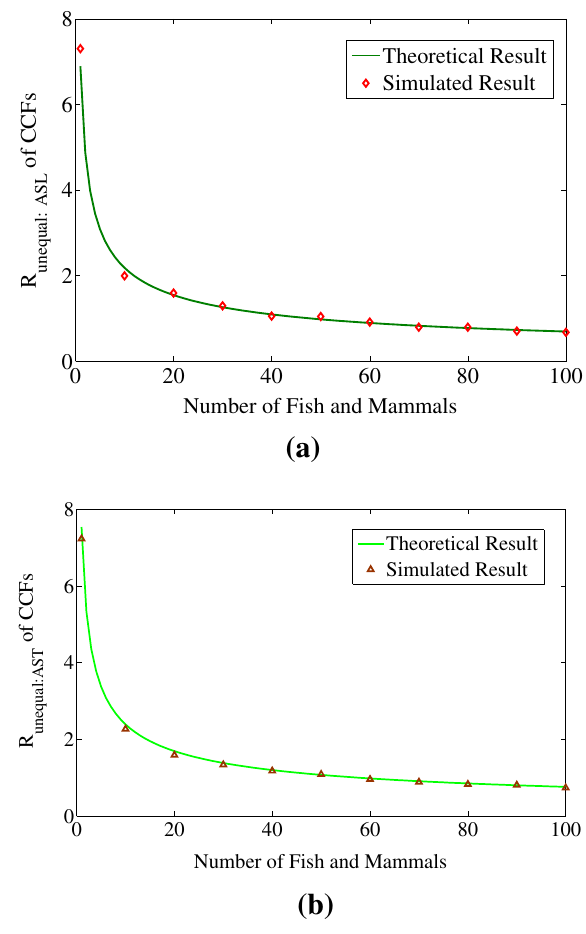
Figure 5. Number of fish and mammal’s vs. R of CCFs for unequal distances among acoustic sensors, ( a ) three acoustic sensors ASL scheme where, d DBS12 = 1 m and d DBS23 = 1.5 m and ( b ) three acoustic sensors AST scheme where, d DBS12 = 1 m, d DBS23 = 1.5 m and d DBS31 = 2 m. We used MATLAB R2010a to achieve these